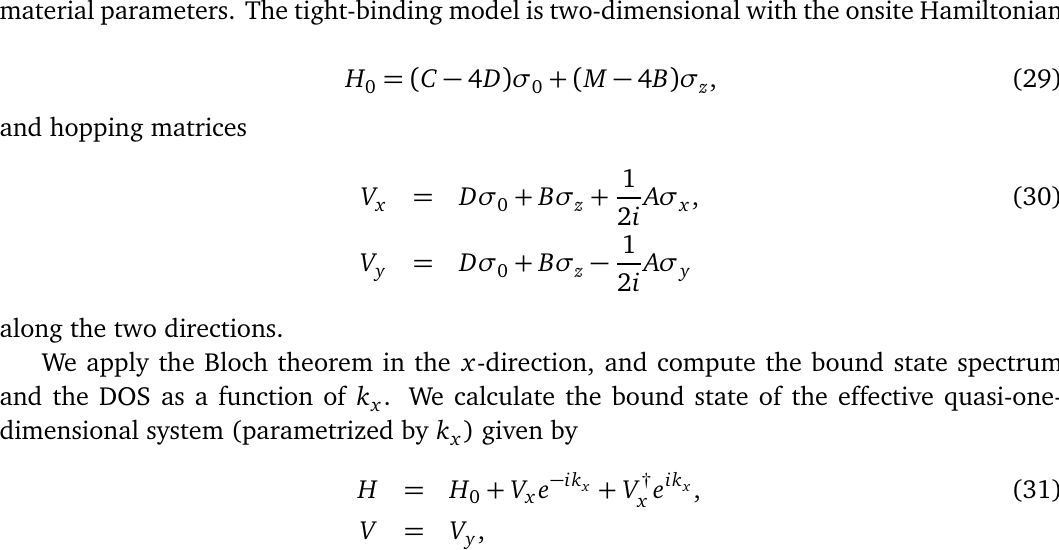
Figure 8: Weight of the Majorana bound state at the system boundary ψ † the chemical potential µ . The solid line is computed using our algorithm, i.e., simulating a semi-infinite system, while the dotted lines correspond to the diagonalization of finite systems with sizes l = 50,100 and 200. The finite size effects are more pronounced close to the critical point where the gap closes, while our algorithm is only limited by machine precision. Insets: zoom of the main